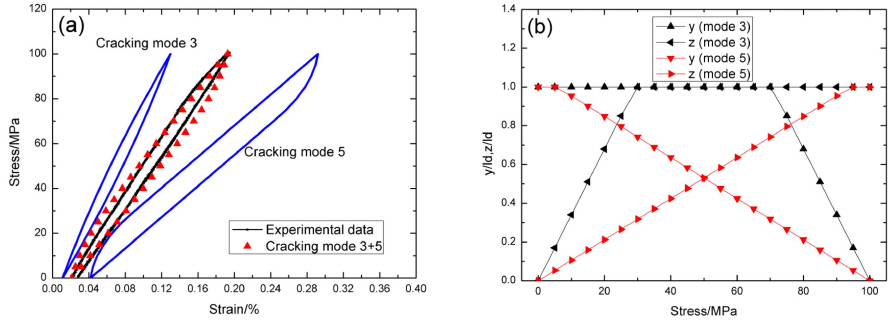
Figure 5. ( a ) The theoretical and experimental hysteresis loops; and ( b ) the interface slip lengths, i.e. , y / l d and z / l d , of matrix cracking mode 3 and mode 5 of cross-ply C/SiC composite when σ max = 100 MPa.